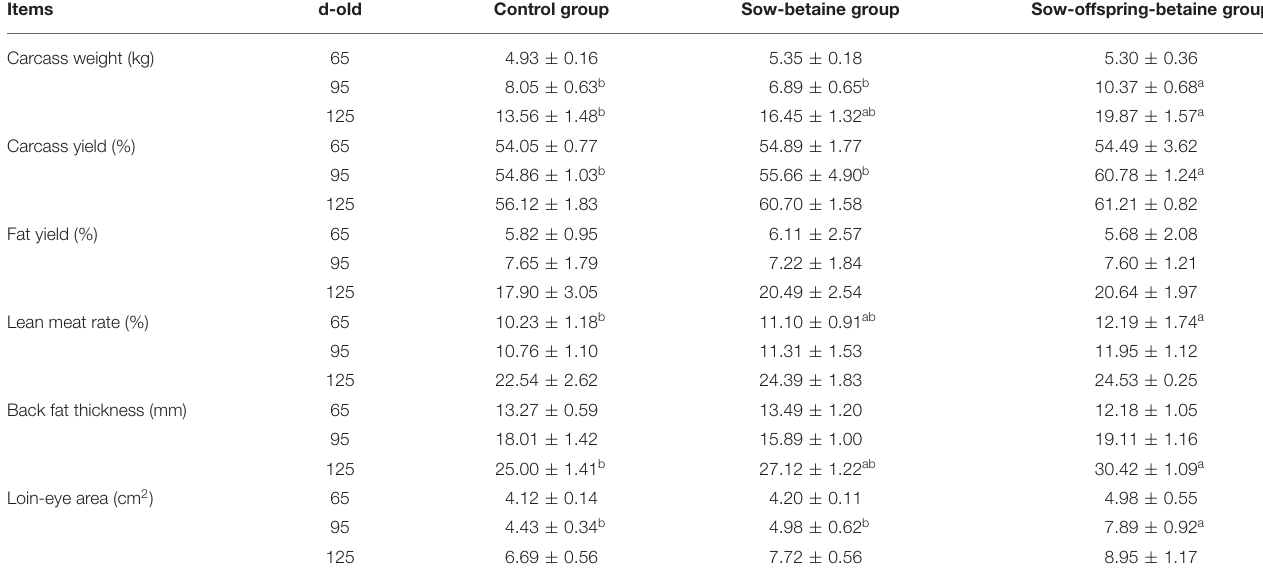
TABLE 1 | Effect of dietary betaine on carcass traits of Bama mini-pigs.